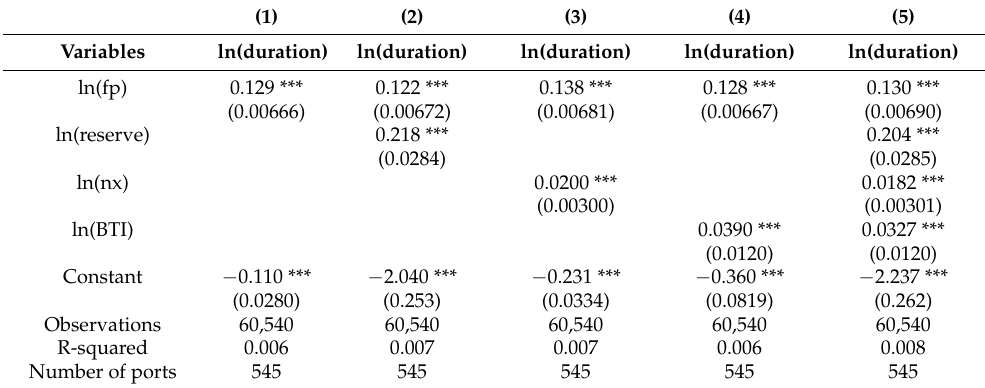
Table 4. Results of fixed-effect regression